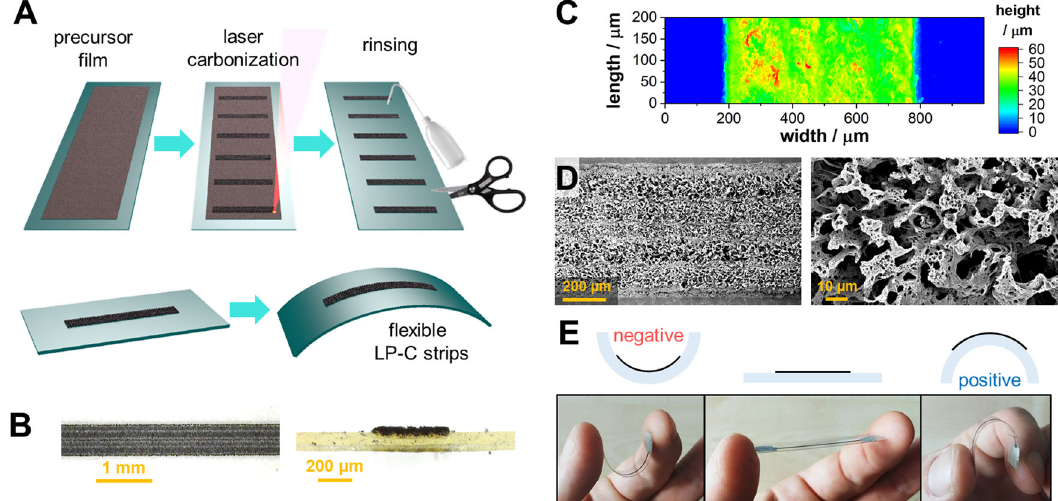
Fig. 1 Fabrication and initial characterization of fl exible LP-C sensor strips. A Scheme of the fabrication process of laser-patterned carbon structures. B Digital optical micrographs of a laser-patterned carbon strip on transparent PET, top view on the left and cross-section on the right. C 2D height pro fi le of a LP-C sensor strip obtained by vertical scanning interferometry. D Scanning electron micrographs of a LP-C fi lm on PET shown in ( B ). E Photographs of the LP-C strip on fl exible PET upon positive and negative